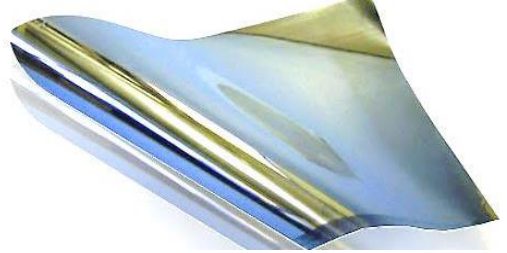
Figure 7. PVDF thin film used to realize the piezoelectric harvester integrated into the smart garment.